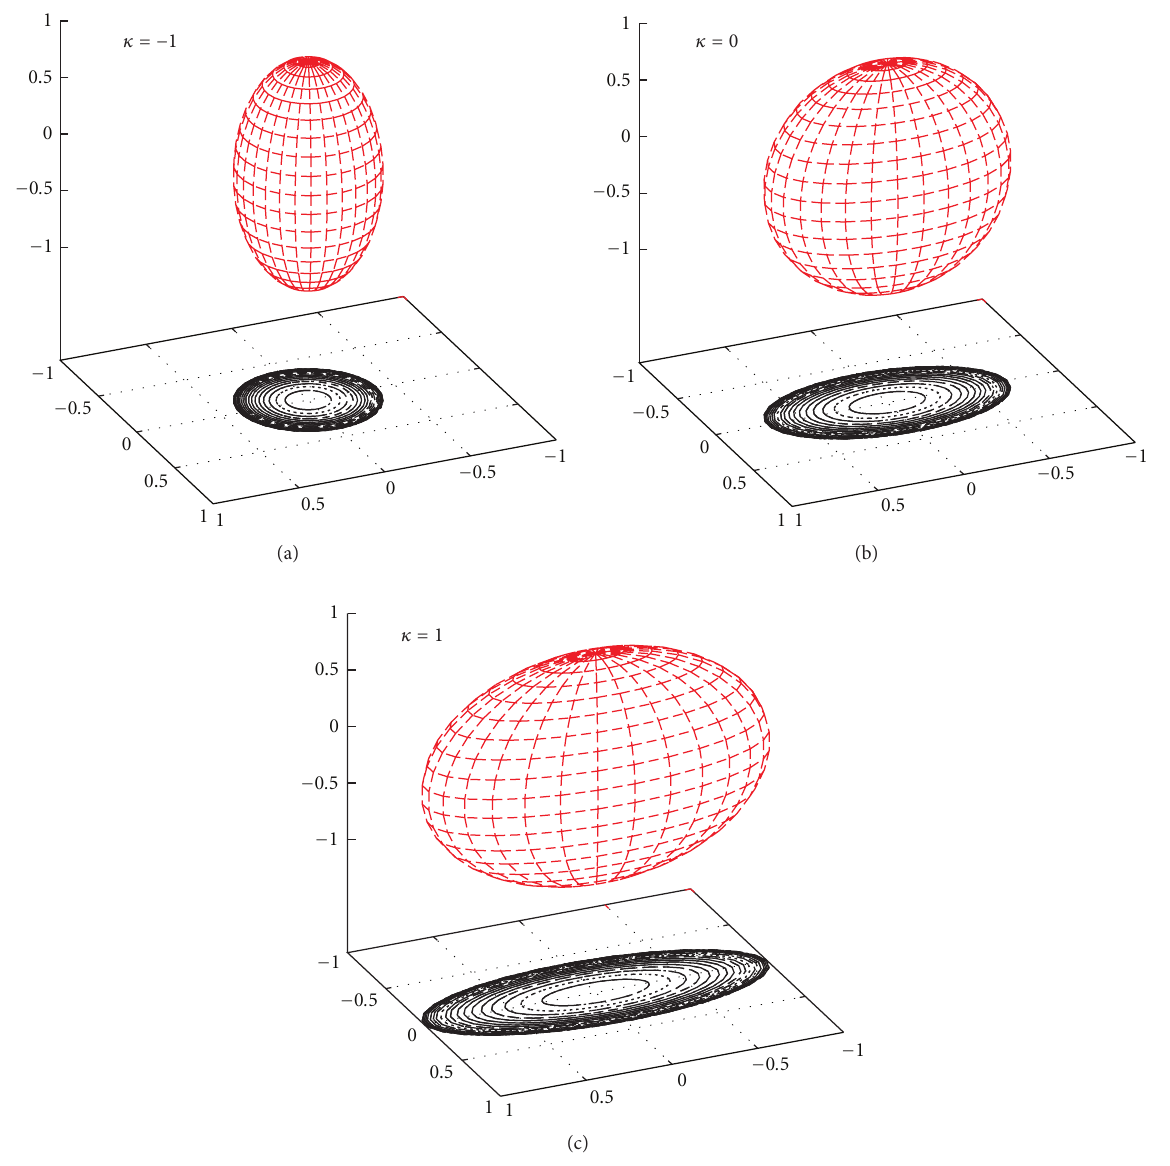
F 2: e moment of inertia ellipsoids for symmetric prolate (a), asymmetric (b), and symmetric oblate (c) molecular